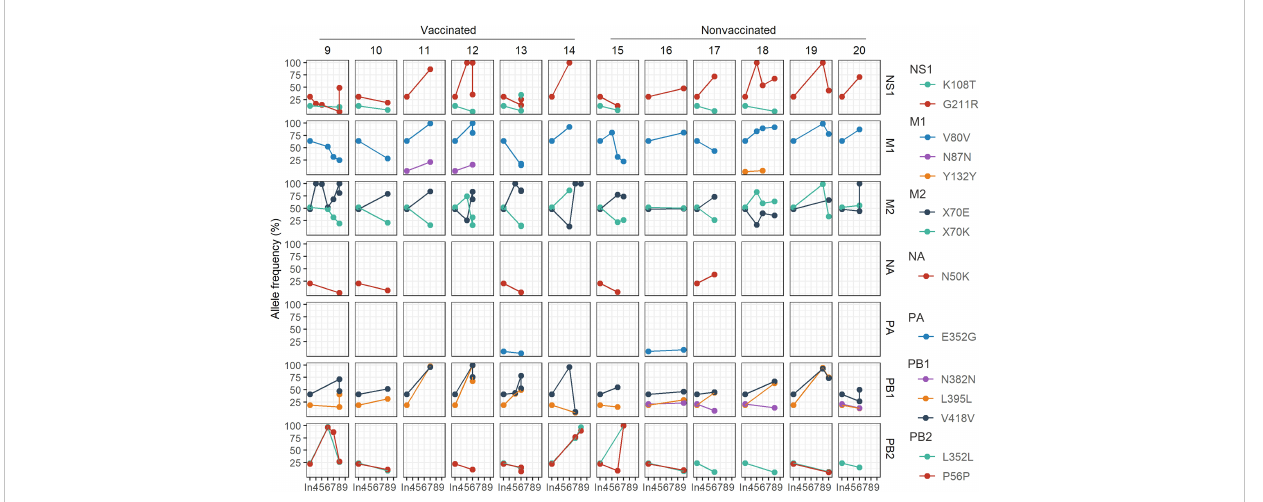
FIGURE 6 Evolution of the allele frequencies of nonsynonymous substitutions detected in H1N1 inoculum and later in samples collected from both experimental groups. The day of variant detection and the allele frequency percentage is represented in ordinate and abscissa axes, respectively. The “ In. ” in x axis indicates the percentage obtained in the inoculum, whereas 4 to 9 numbers indicate the days post-inoculation. In each column, the different animals are represented while in each row NS1, M1, M2, NA, PA, PB1, and PB2 proteins are indicated. Each mutation is plotted in different colors.